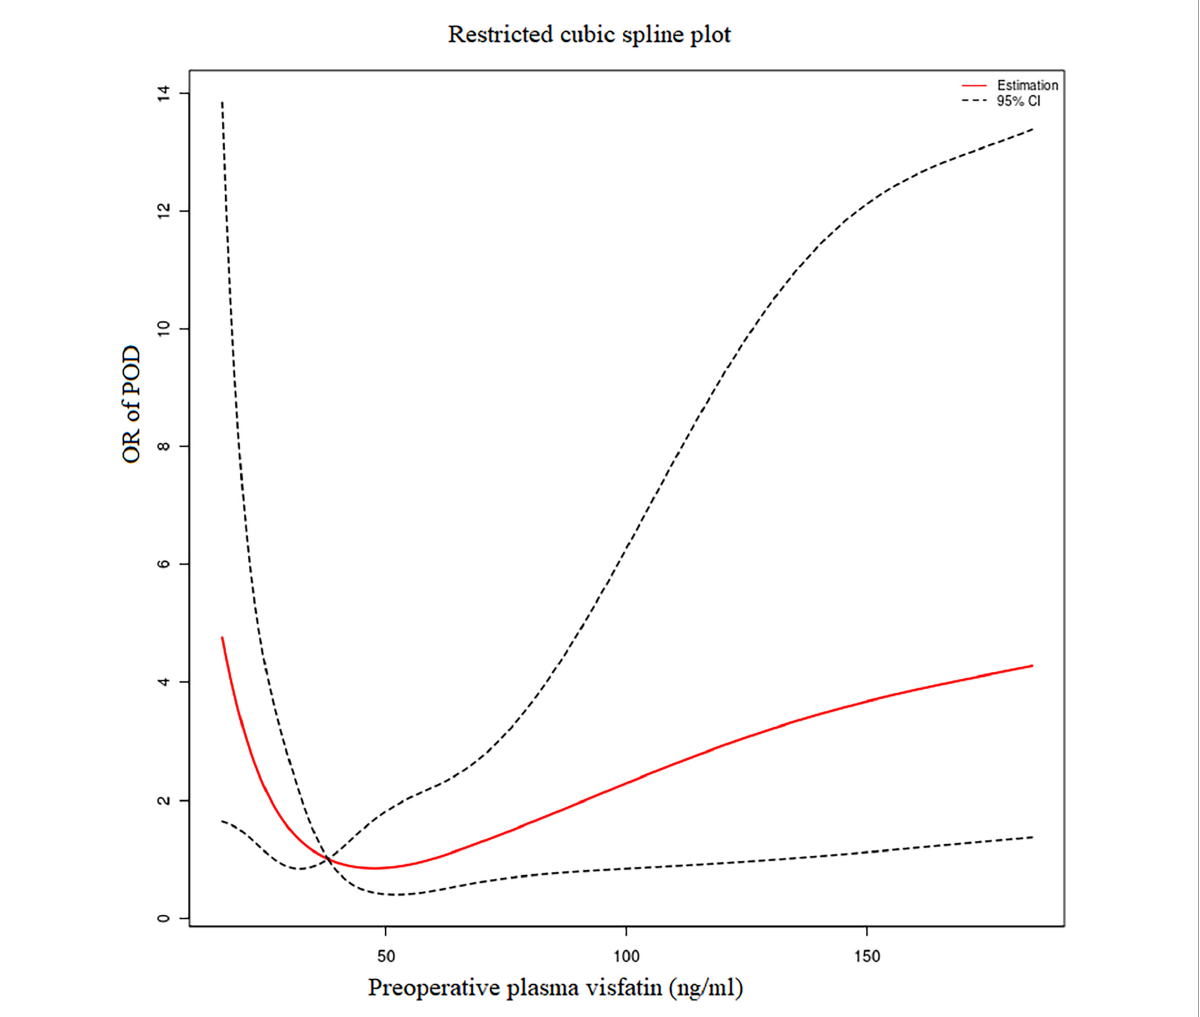
FIGURE2 Restricted cubic spline analysis results. The relationship between the preoperative visfatin levels and OR of POD. OR, odd ratio; POD, postoperative